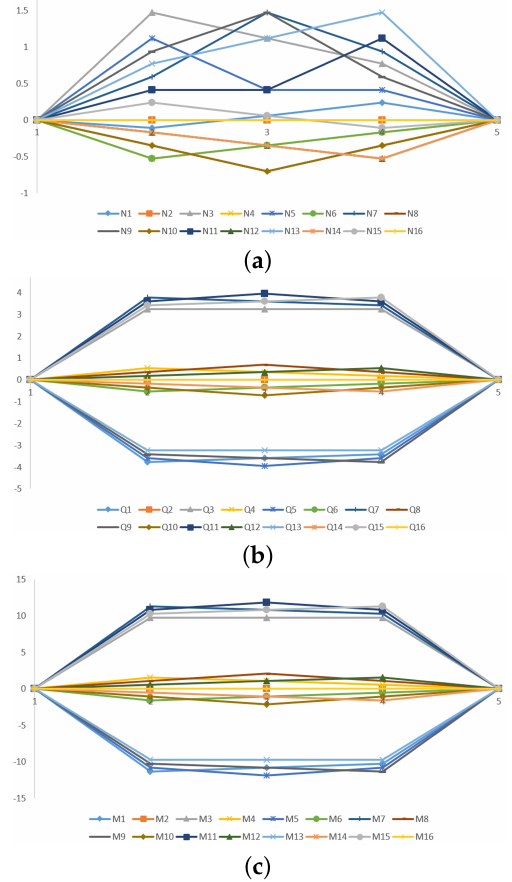
Figure 12. I.L. diagram of AFD N , SFD Q , and BMD M of CSCI by H-25 truck. ( a ) I.L. of AFD N at the normal CSCI. ( b ) I.L. of SFD Q at the middle of CSCI. ( c ) I.L. of BMD M at the middle of CSCI.